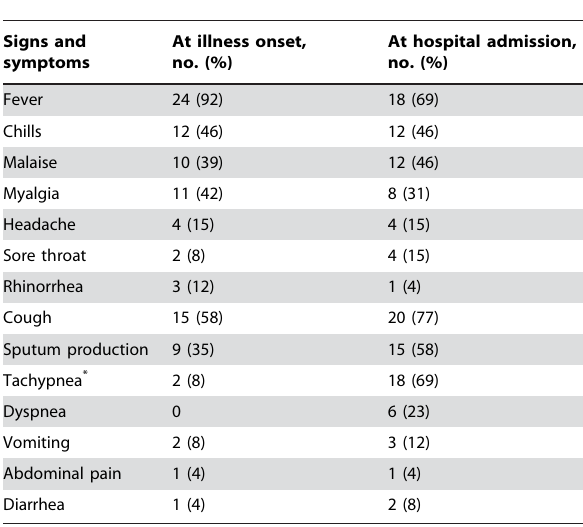
Table 1. Signs and symptoms of 26 H5N1 cases at illness onset and at hospital admission, China.